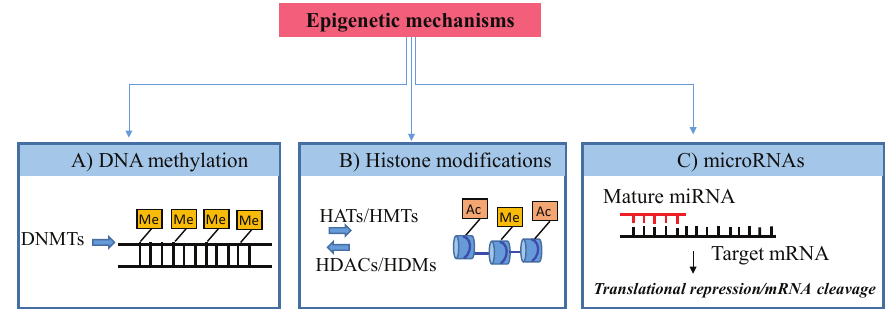
Figure 1. Scheme of Epigenetic mechanisms. Epigenetic mechanisms: ( A ) DNA methylation (Me) of cytosine residues within gene sequences that leads to transcriptional silencing. ( B ) Histone modifications include methylation (Me) and acetylation (Ac) that can lead to either activation or repression of gene transcription. ( C ) MicroRNAs are small RNAs able to regulate gene expression by paring to target mRNA sequences inducing target degradation or inhibition of translation. DNMTs, DNA methyltransferases; HATs, histone acetyltransferases; HDACs, histone deacetylases; HMTs, histone lysine methyltransferases; HDMs, histone lysine